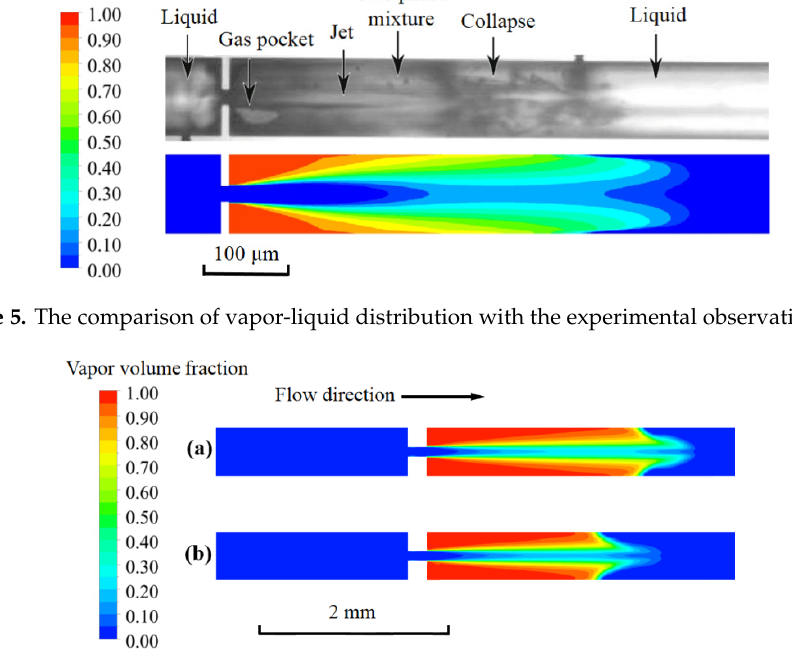
Figure 6. The vapor-liquid distribution of the fluids: ( a ) deionized (DI) water; and, ( b ) nano-fluid.